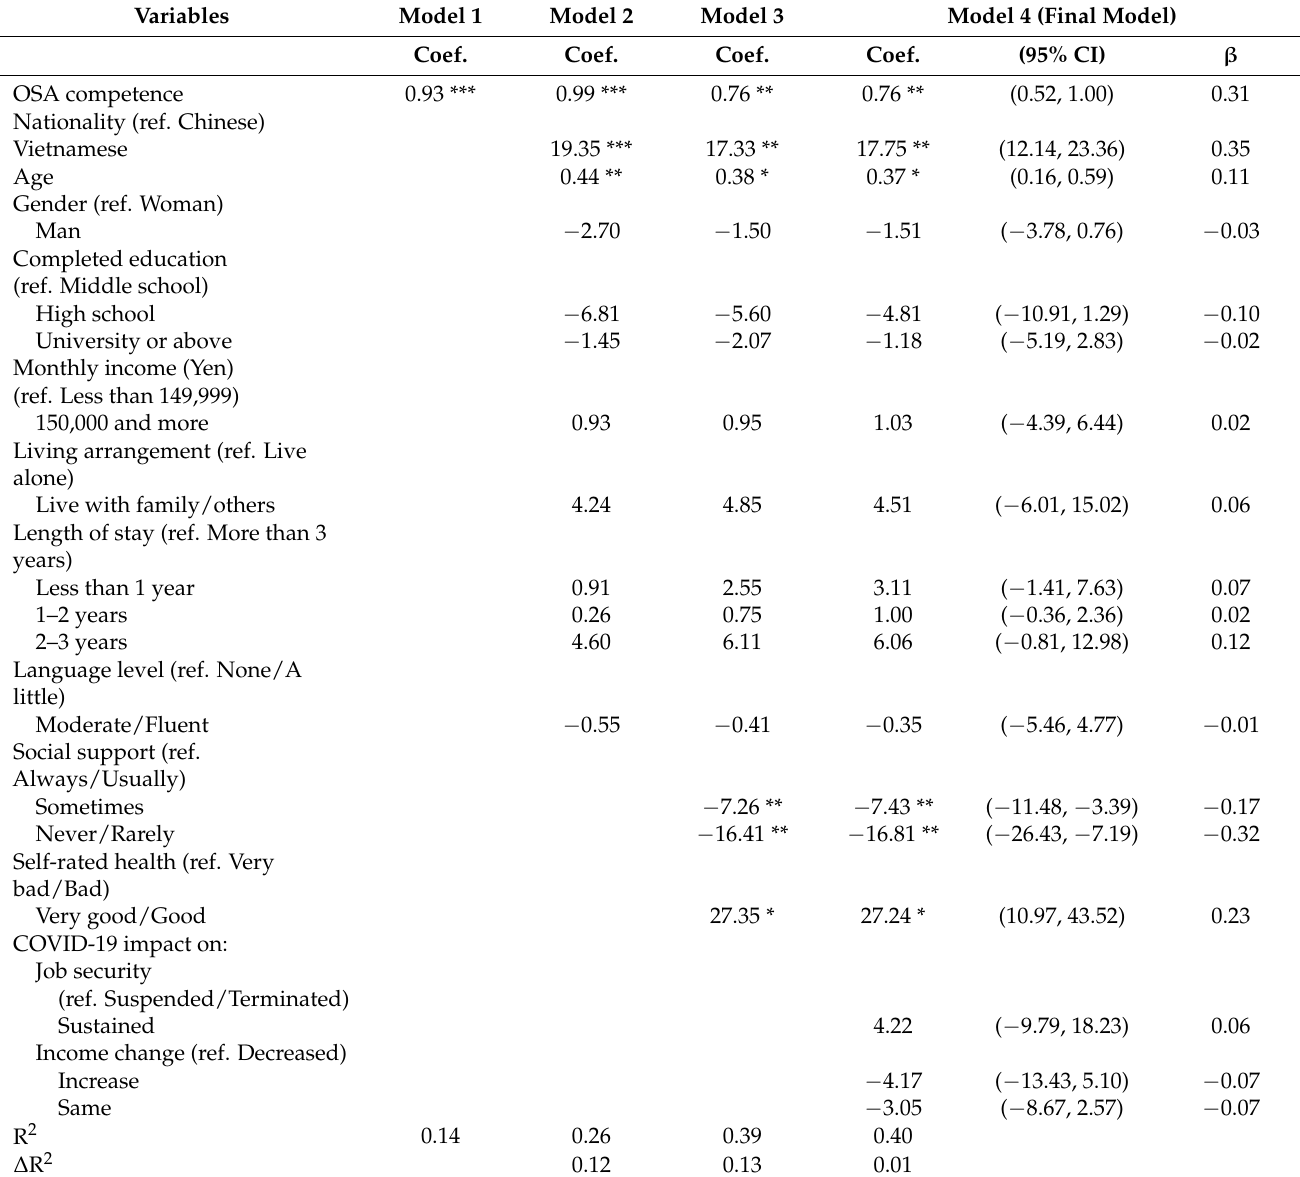
Table 2. Hierarchical regression analysis predicting the mental well-being among technical intern trainees in Japan ( n =